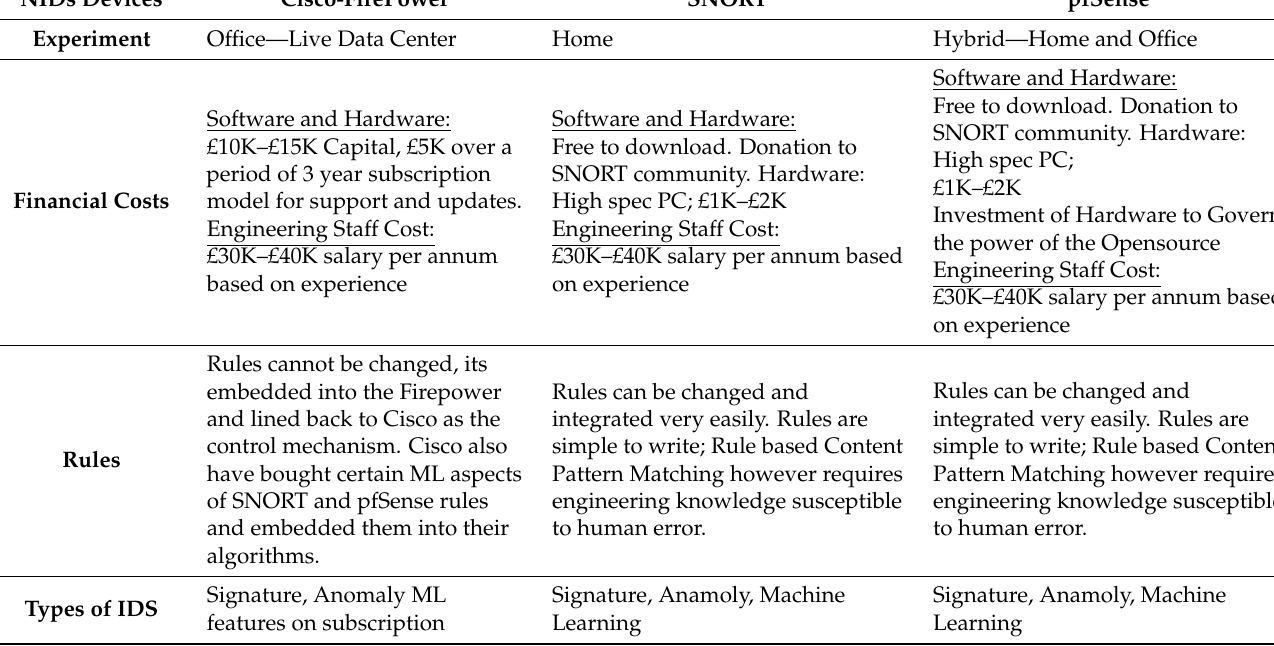
Table 1. NIDS Device